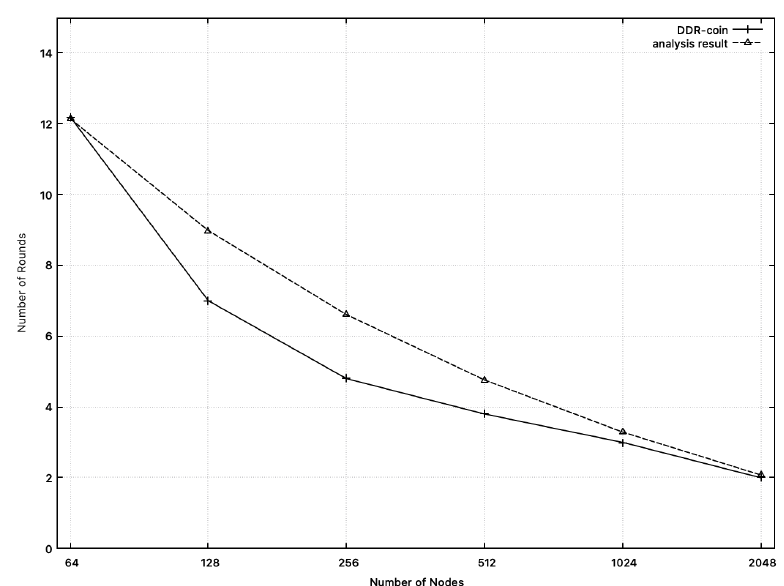
Figure 7. Numbers of rounds: the measured numbers from simulations and the analysis results from Section 3 when n = 2 6 ∼ 2 11 , w = 10,000. The solid line represents the measured numbers from simulation. The dotted line (analysis results) represents the function: 10 · log